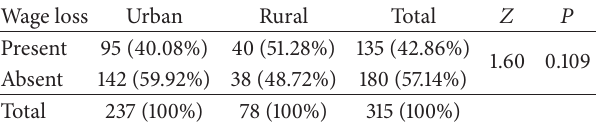
Table 8: Distribution of the study population according to the presence of wage loss due to their visit to Medical College Hospital in the last three months ( 𝑛 = 315 ). Wage